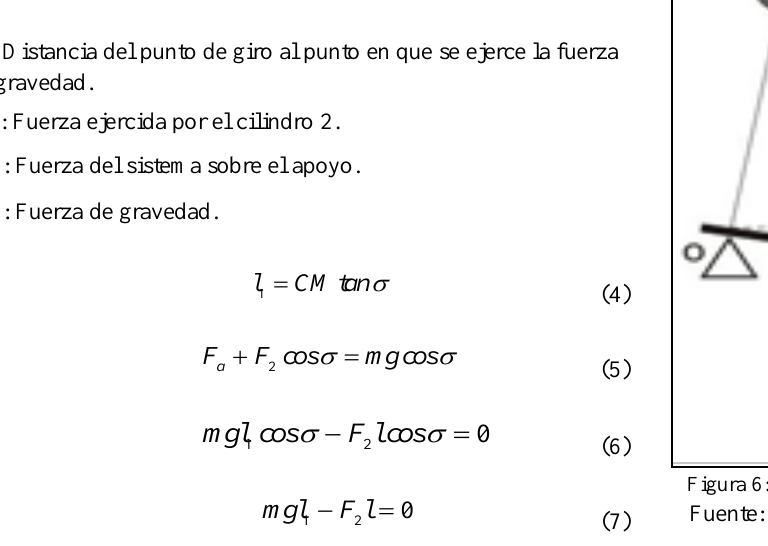
Figura 4: Diagrama de fuerzas correspondiente al análisis desacoplado. Fuente: Autores, (2015).